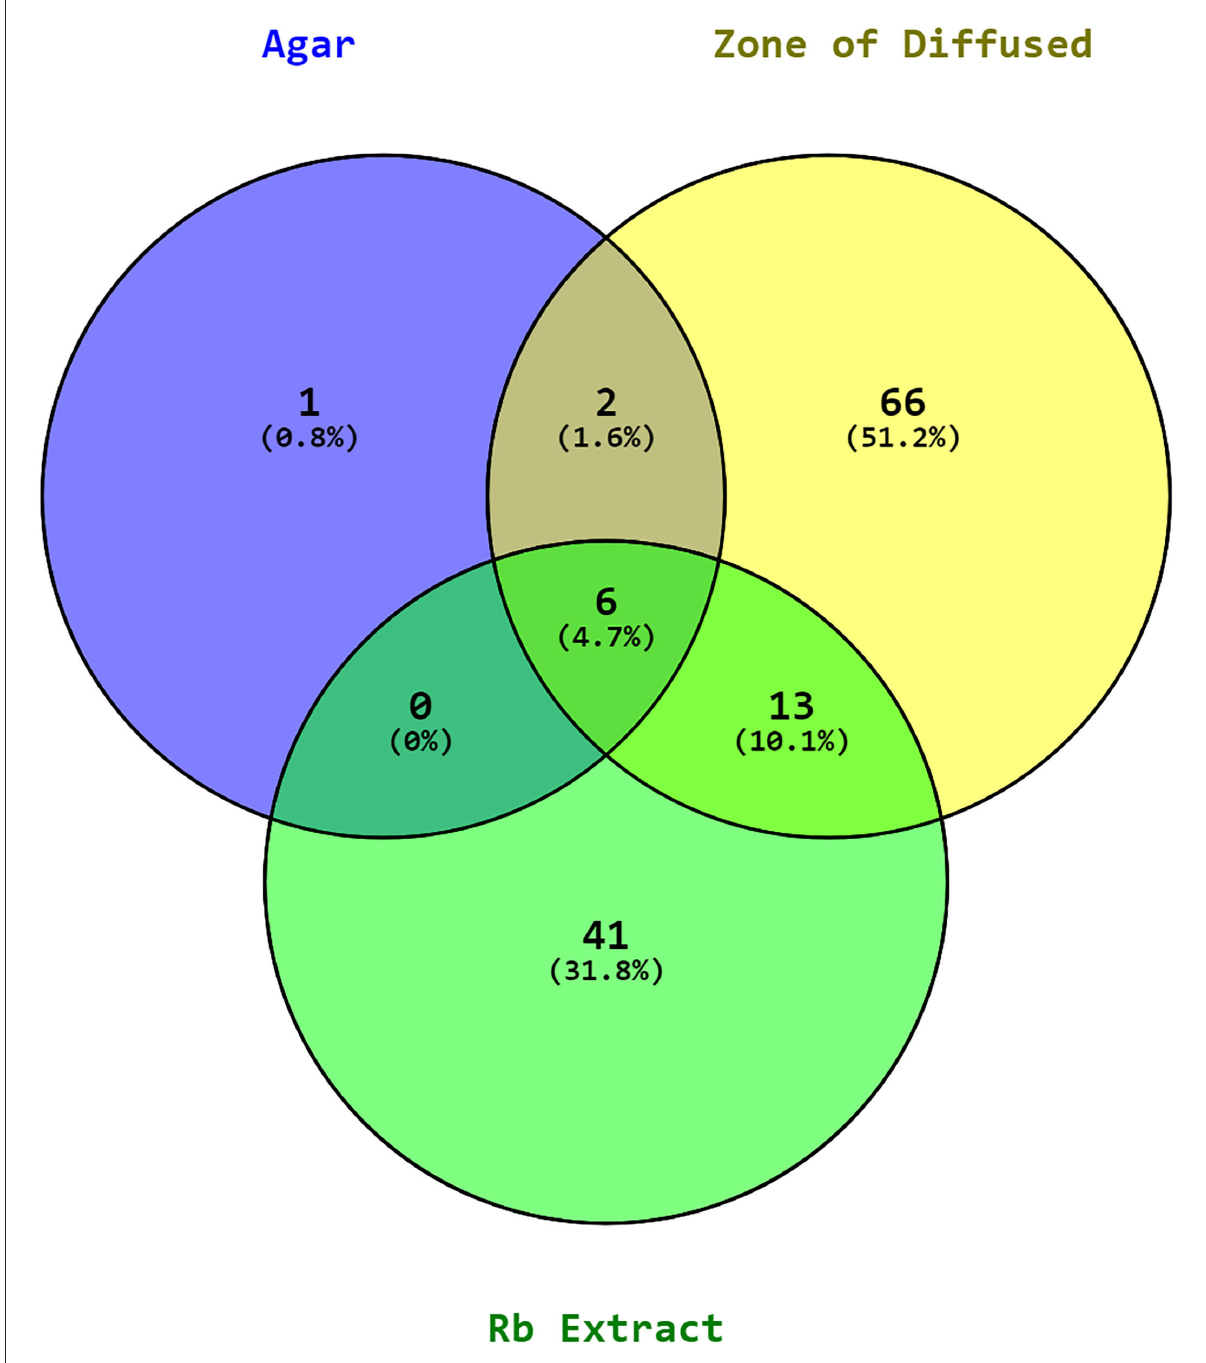
FIGURE12 Venn diagram of metabolites in the RB ( P. aeruginosa RKC1) extract, the clear zone around the well, and agar.